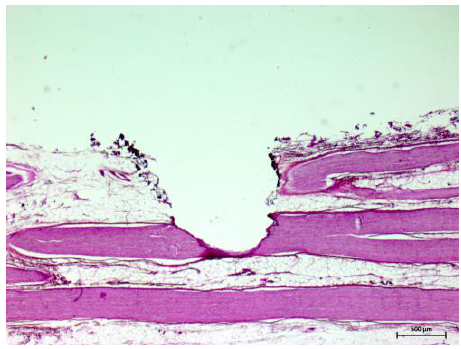
Figure 6. Nerve tissue with laser ablation crater after 10 pulses